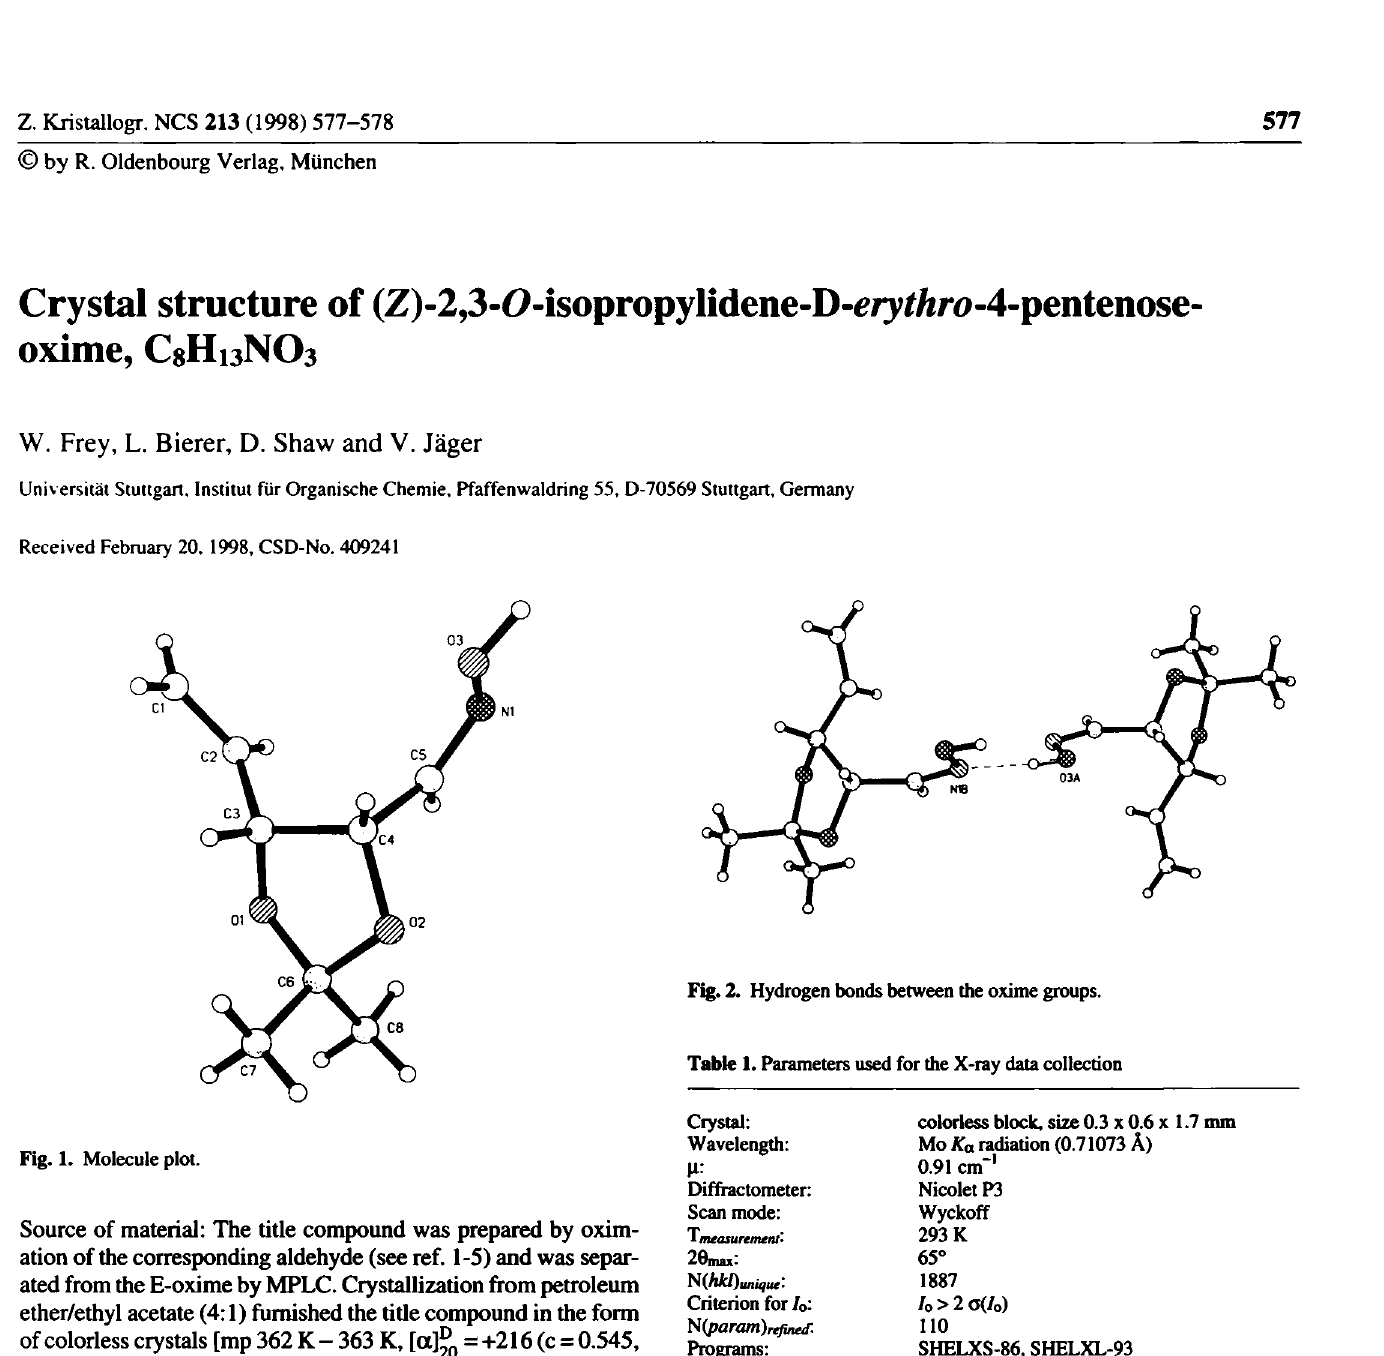
Table 2. Final atomic coordinates and displacement parameters (in